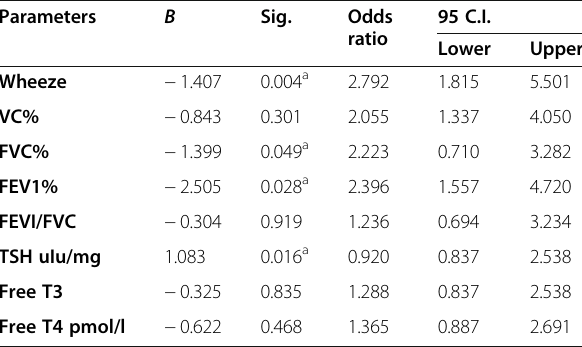
Table 6 Logistic linear regression of the predictive factors for diaphragmatic excursion affection in patients ’ group